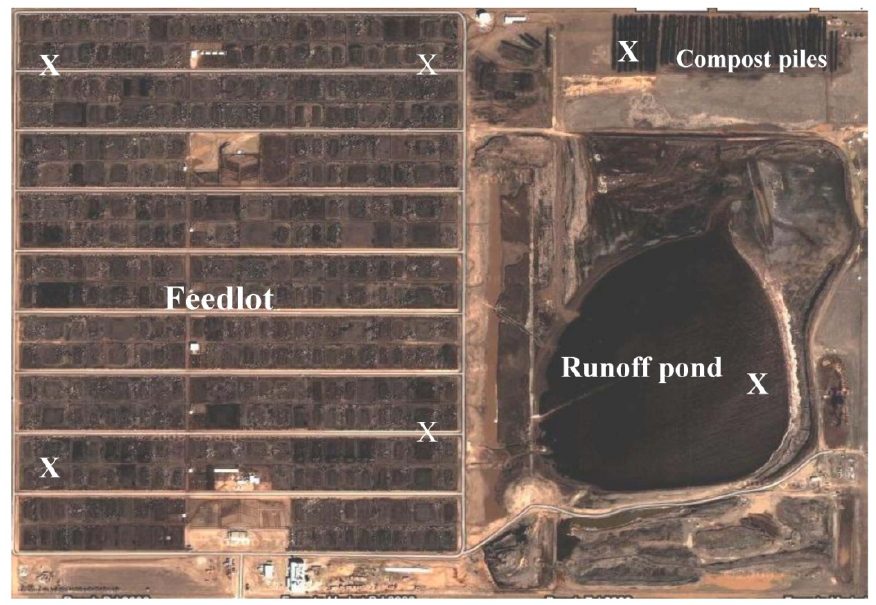
Figure 2. Aerial photograph of the beef cattle feedyard located at the Texas